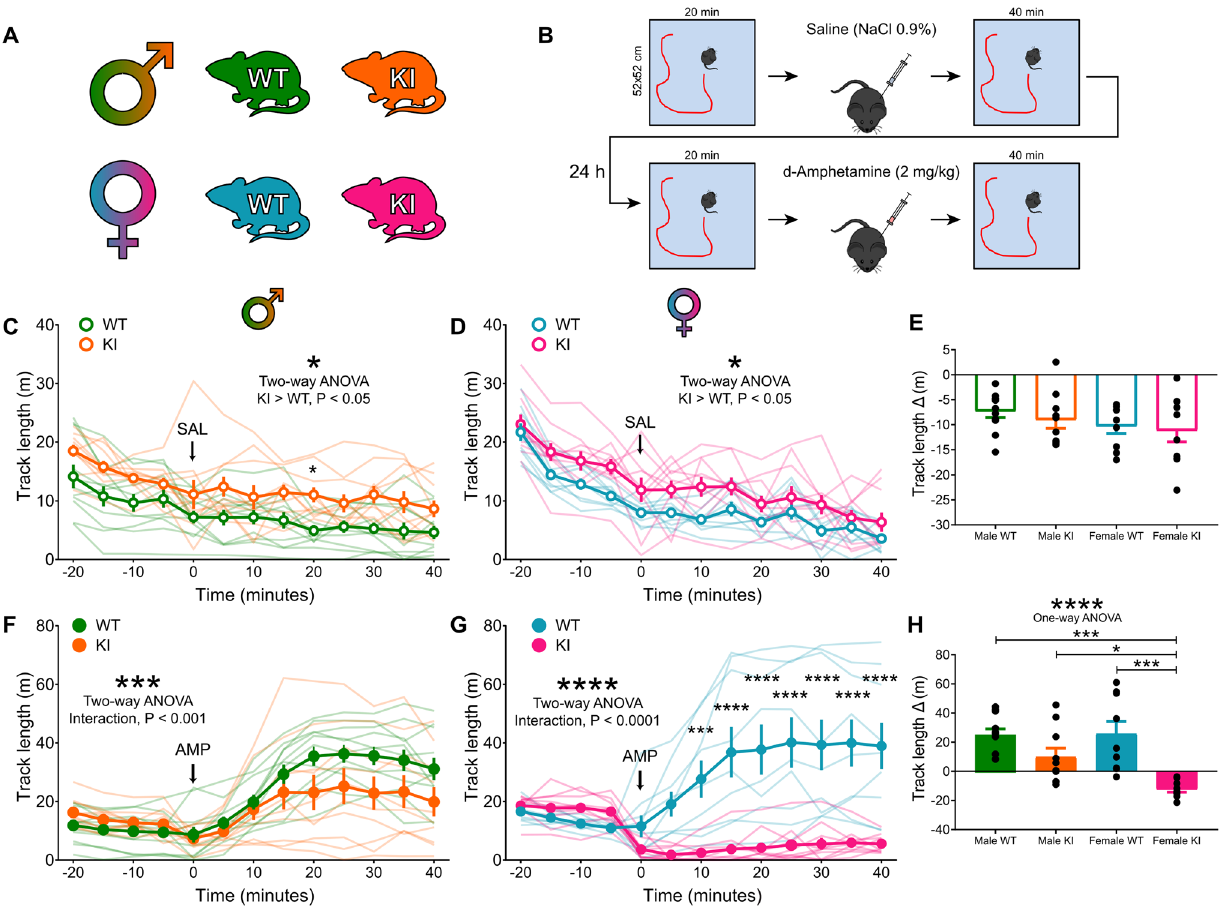
Figure 1. DAT-Cre KI mice have sex-dependent changes in baseline and amphetamine-induced locomotor activity. ( A ) Mice were divided according to their genotype and sex. The color-coding scheme illustrated here applies to all other figures in this study. ( B ) Mice were placed in an open field for 20 min, given a saline injection, and returned to the arena for 40 min. The next day animals went through a similar procedure, except they received injections of d-amphetamine (2 mg/kg). ( C ) Total distance travelled (5-min bins) for male WT and KI mice. KI mice displayed a hyperlocomotor phenotype. Note that saline injection creates only a minimal disruption in behavior. ( D ) Same as ( C ), but for females. Note that female KIs were also hyperactive. ( E ) Difference in distance travelled between the last and first 20 min of the experiment. There was no significant difference between groups. ( F ) Locomotor activity of male mice before and after d-amphetamine injections. Male KIs showed a blunted response to the drug. ( G ) Same as E, but for females. While WT females show increases in open field locomotion after the amphetamine injections, KI females decreased their activity. ( H ) Same as ( E ), but for the amphetamine experiment. Note that most groups showed an average increase in locomotion, except for the female KIs, which showed a consistent reduction in activity. Asterisks atop specific data points indicate multiple comparison tests results between groups. * P < 0.05; ** P < 0.01; *** P < 0.001; **** P <